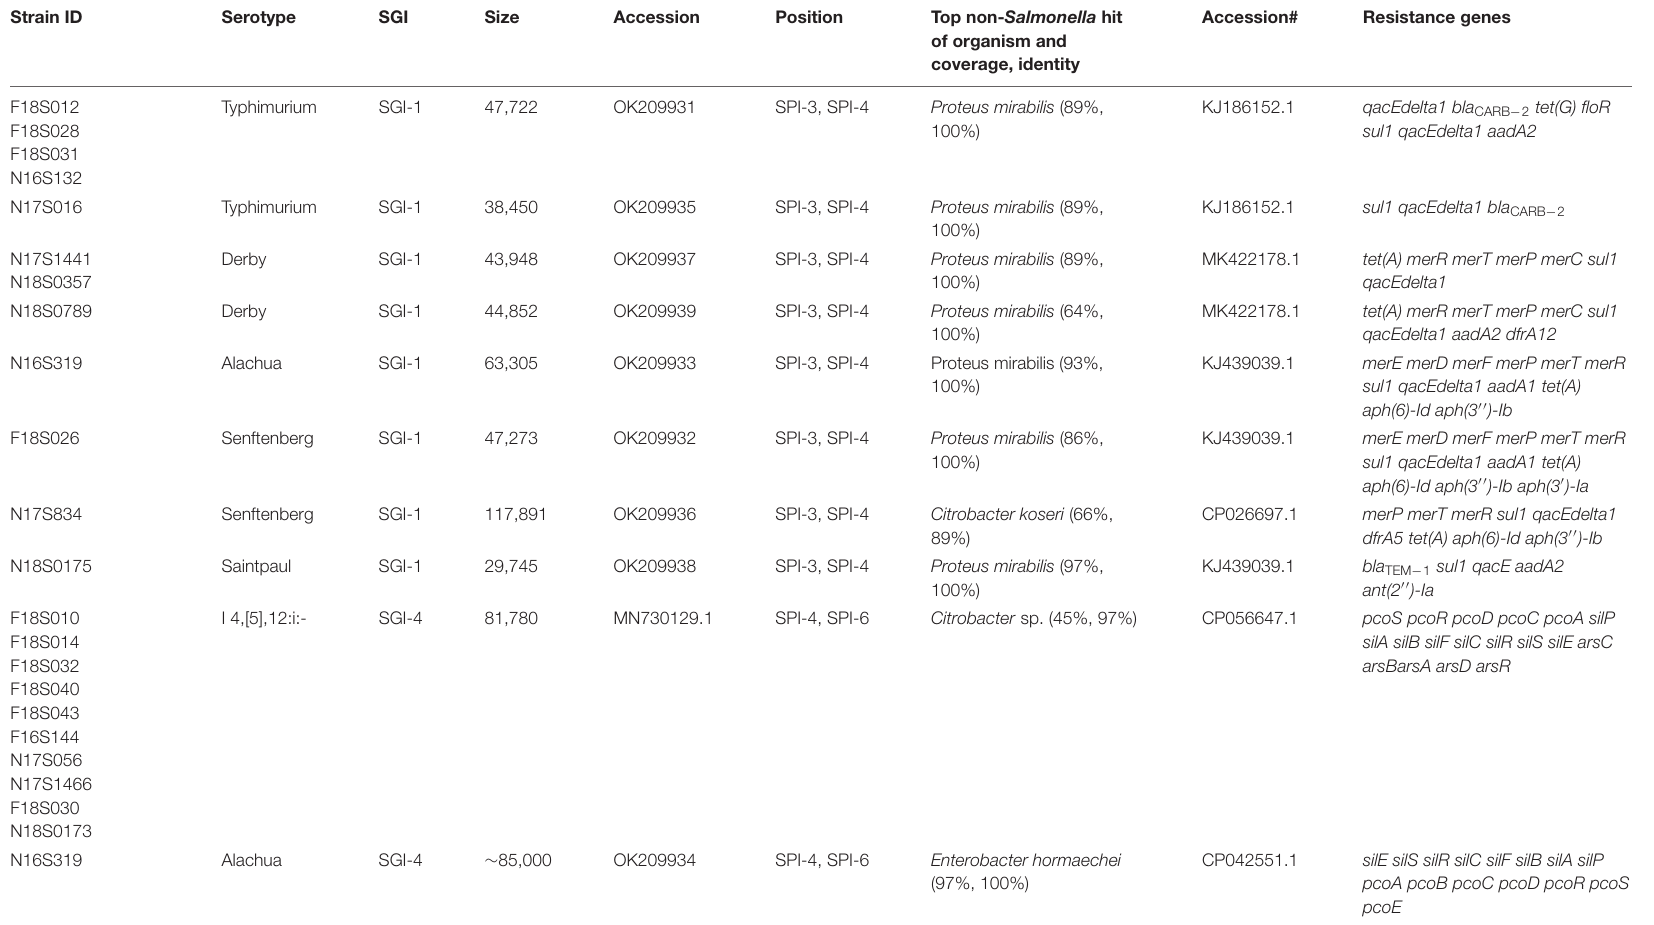
TABLE 1 | Putative Salmonella genomic islands in the genomes of Salmonella isolates. Strain